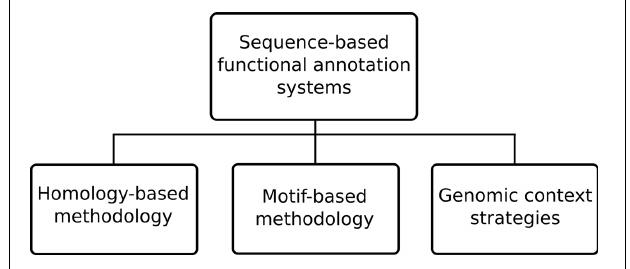
FIGURE 2 | Common approaches in sequence-based functional annotation